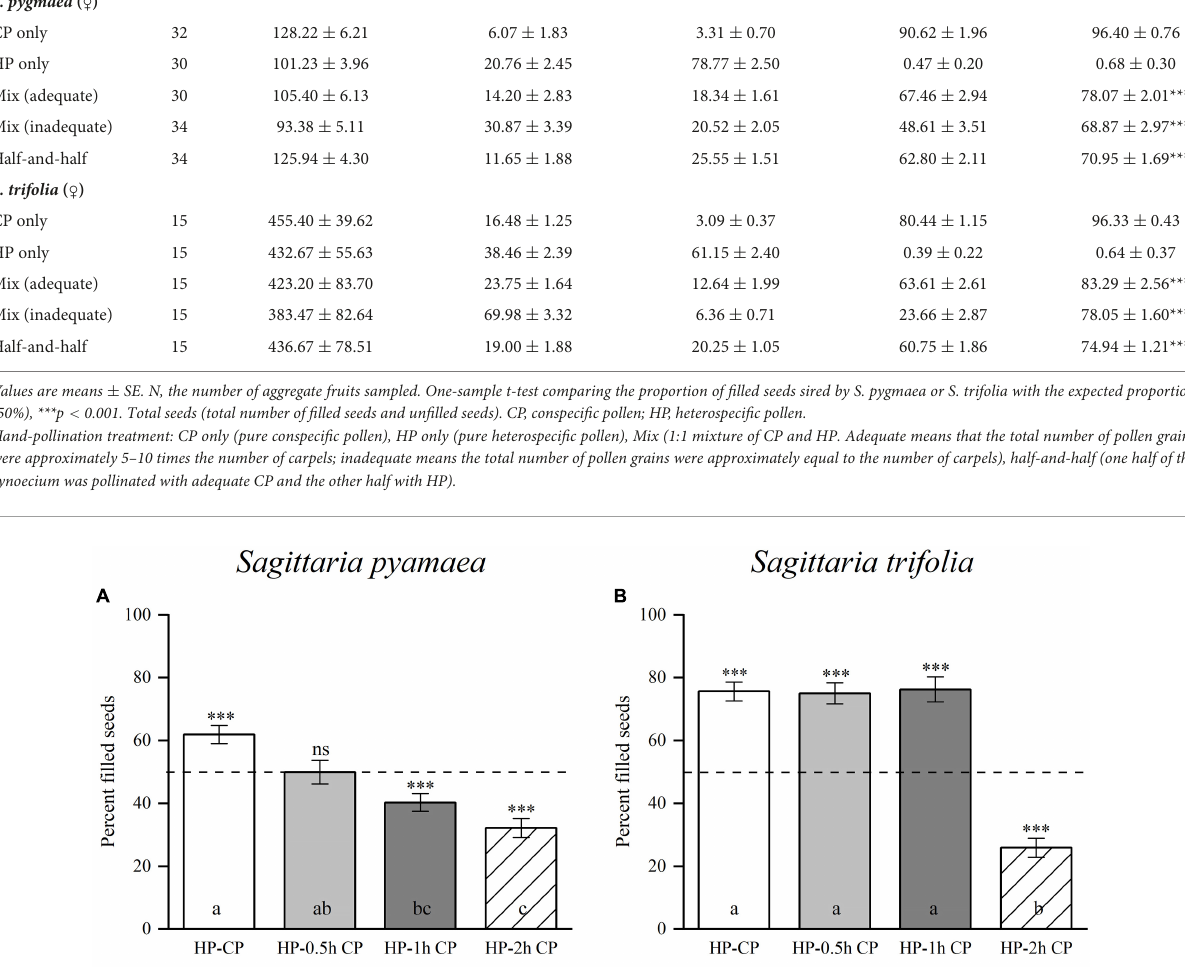
Carpels Carpels with Carpels with Filled seeds/ without seeds/ unfilled seeds/ filled seeds/ Total seeds Total carpels Total carpels Total carpels ( % ) (%) (%) (%)